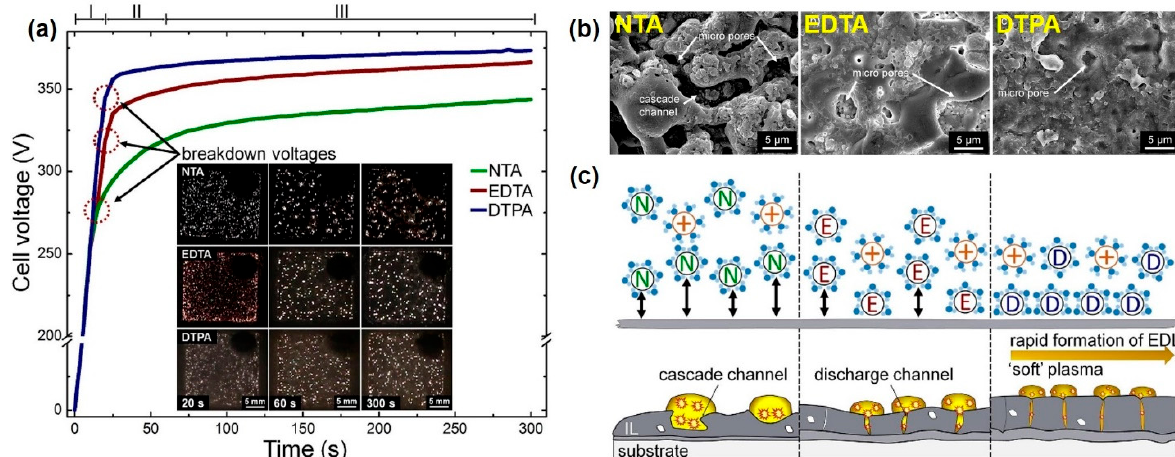
Figure 2. ( a ) Voltage-time response of the PEO process performed in the alkaline-silicate electrolyte with nitrilotriacetic acid (NTA), ethylenediaminetetraacetic acid (EDTA), and diethylenetriaminepentaacetic acid (DTPA). Insets are the appearance of plasma discharges at the end of stage I (~20 s), stage II (~60 s), and stage III (~300 s). ( b ) SEM images showing the surface morphologies of the coatings produced in electrolytes with NTA, EDTA, and DTPA. ( c ) Schematic illustration showing the reconstruction of an electrical double layer (EDL) in electrolytes containing NTA, EDTA, and DTPA and their effects on the generation of soft plasma discharges underlying the formation of PEO coatings. Reprinted from permission from [55]. Copyright 2020 Elsevier.